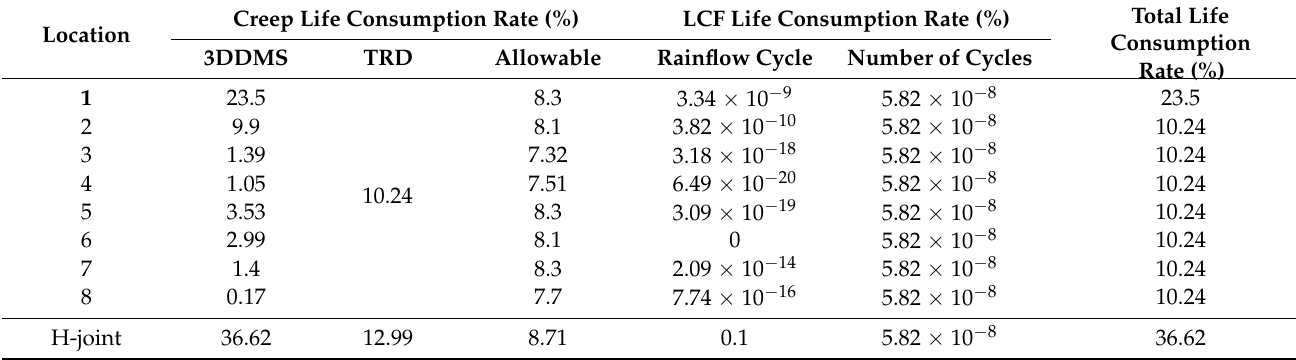
Table 8. Results of life consumption rate with different locations of the main steam pipe by considering the total operating